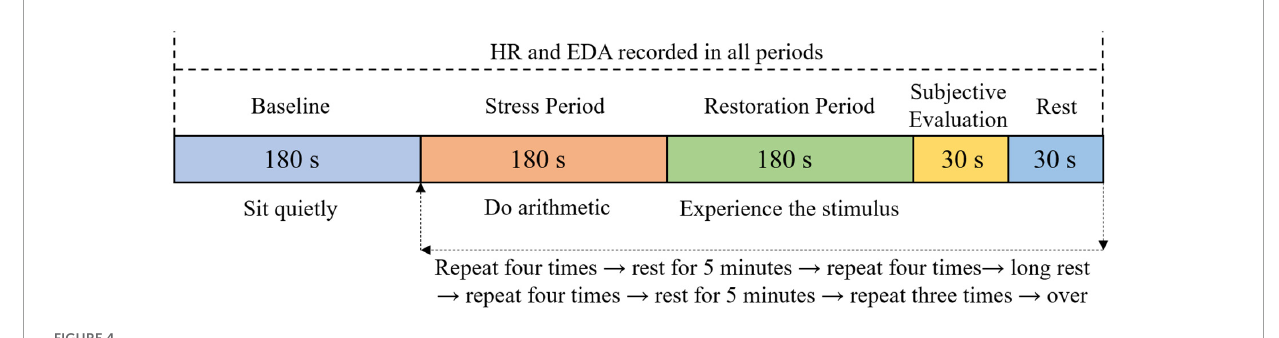
FIGURE4 Experiment procedure for each group.